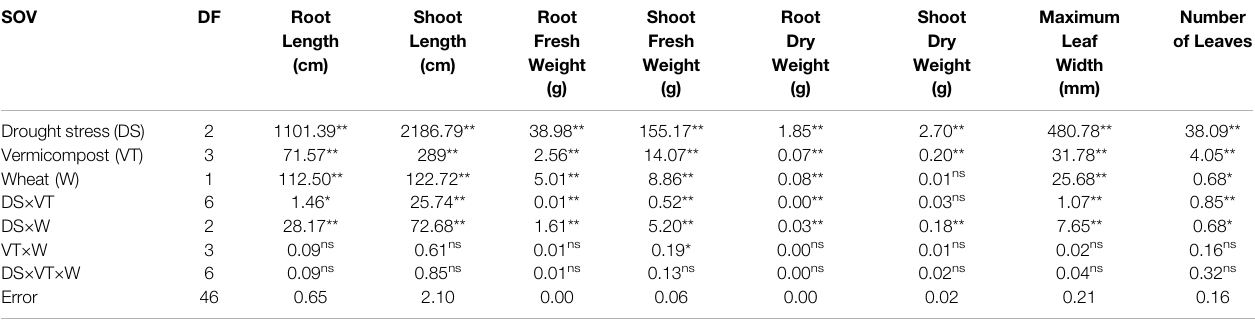
TABLE 3 | Mean sum of squares regarding the effect of soil-applied cellulolytic microbe-enriched rice straw vermicompost on the morphological growth of wheat cultivars under different drought levels. SOV